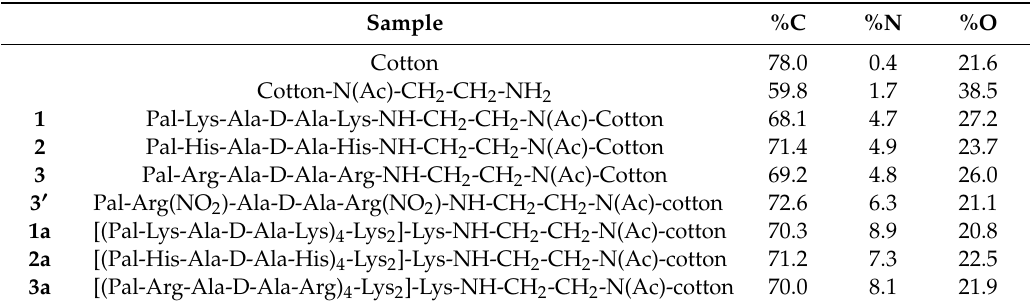
Table 2. Atomic concentration of C, N, and O detected by X-ray Photoelectron Spectroscopy (XPS) on our peptide-cotton samples.